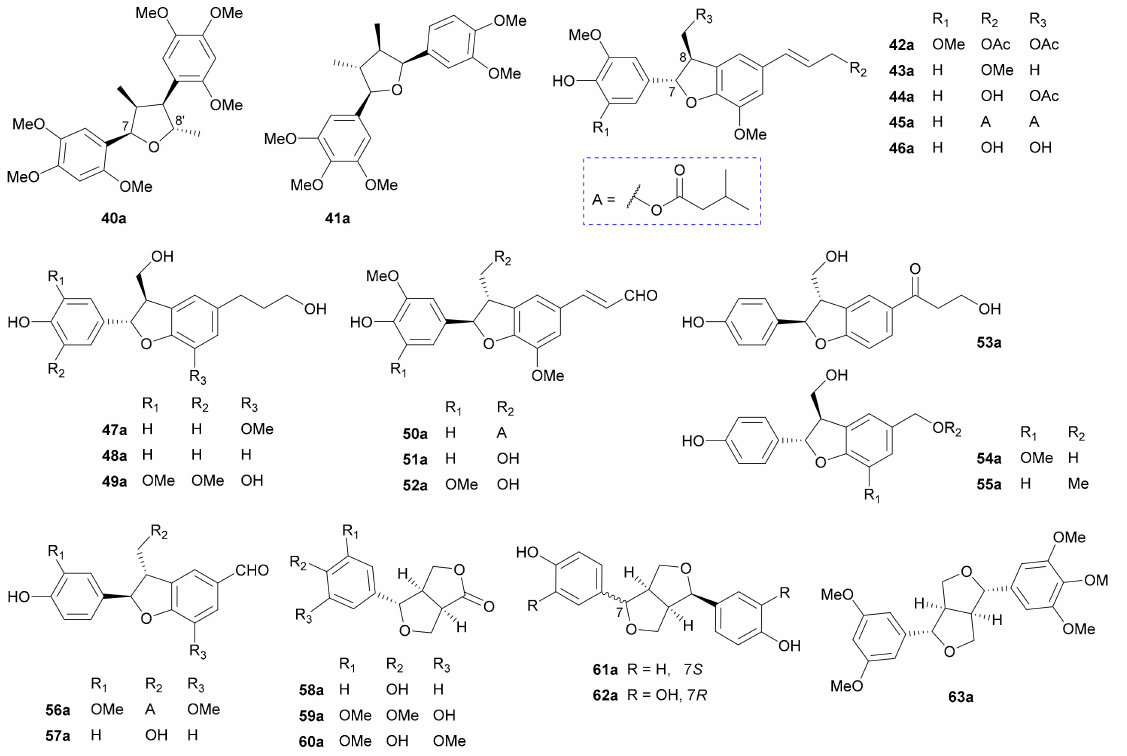
Figure 3. Structures of Furan-incorporating